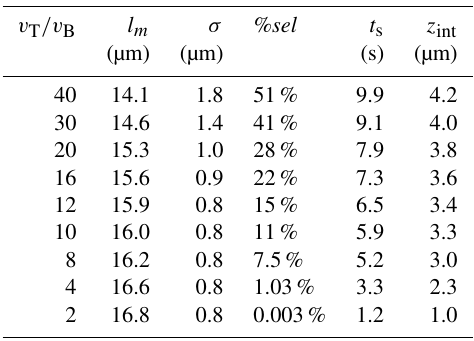
Table 3. Constant-core model predictions of induced unannealed fission-track length measurements in Durango apatite based on user selection